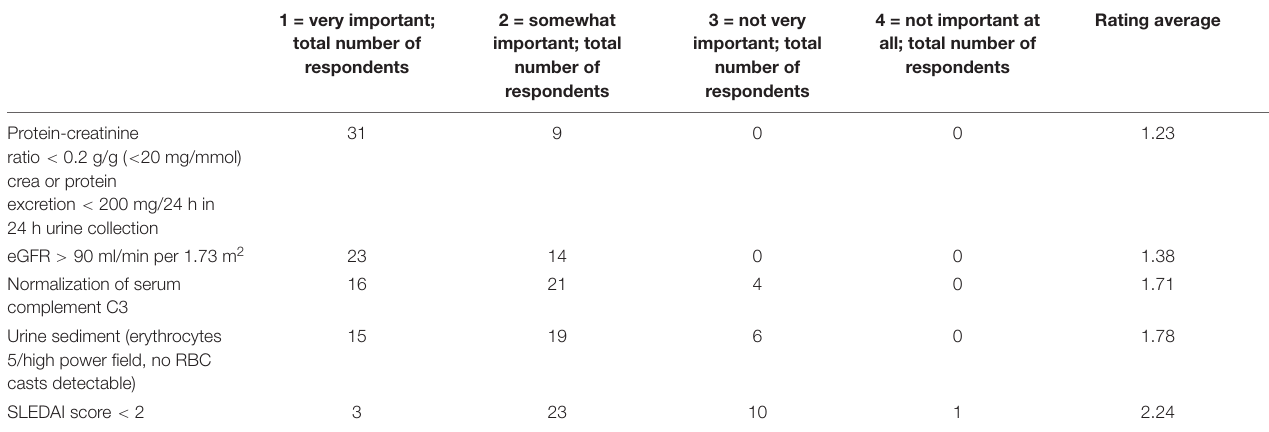
TABLE 5 | Suggested criteria in assessing remission in lupus nephritis (answers by Likert scale: 1 = very important, 2 = somewhat important, 3 = not very important, 4 = not important at all; with rating average of respondents).